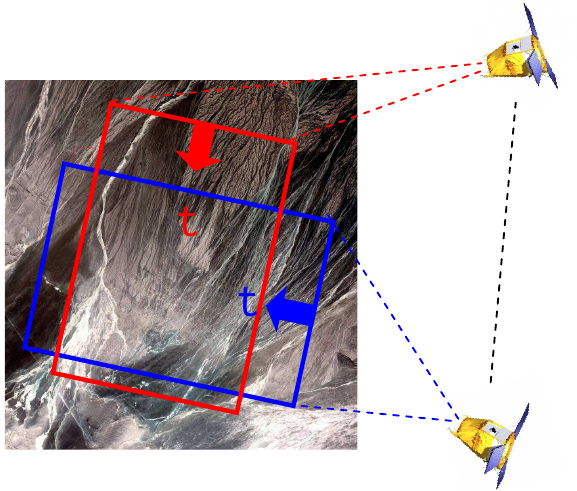
Figure 10 : “ Cross-mode” acquisition principle